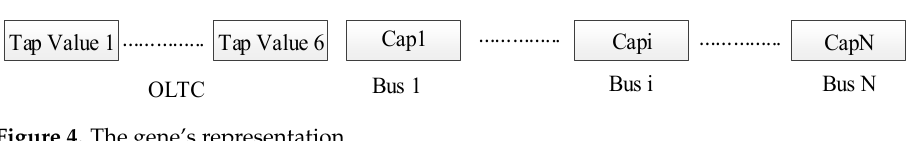
Figure 4. The gene’s representation.